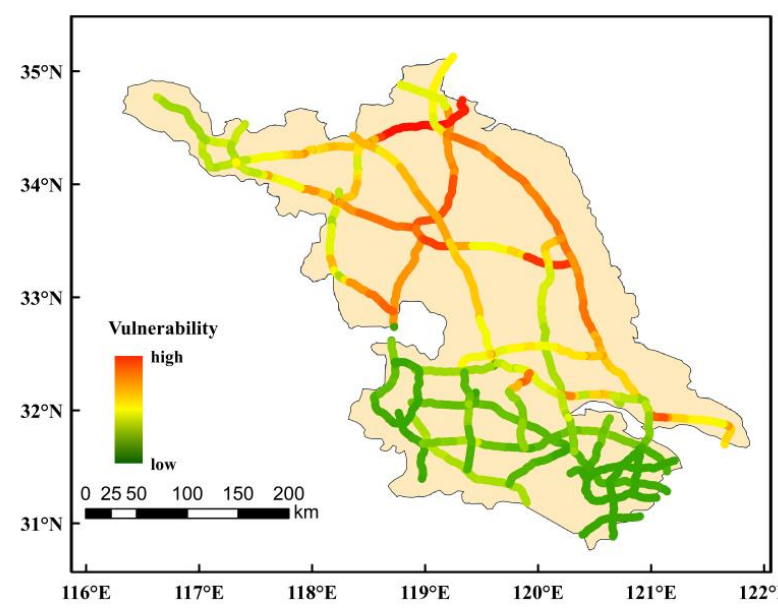
Figure 9. Distribution map of highway vulnerability in Jiangsu Province. Table 3. Weights of indicators for the vulnerability assessment.